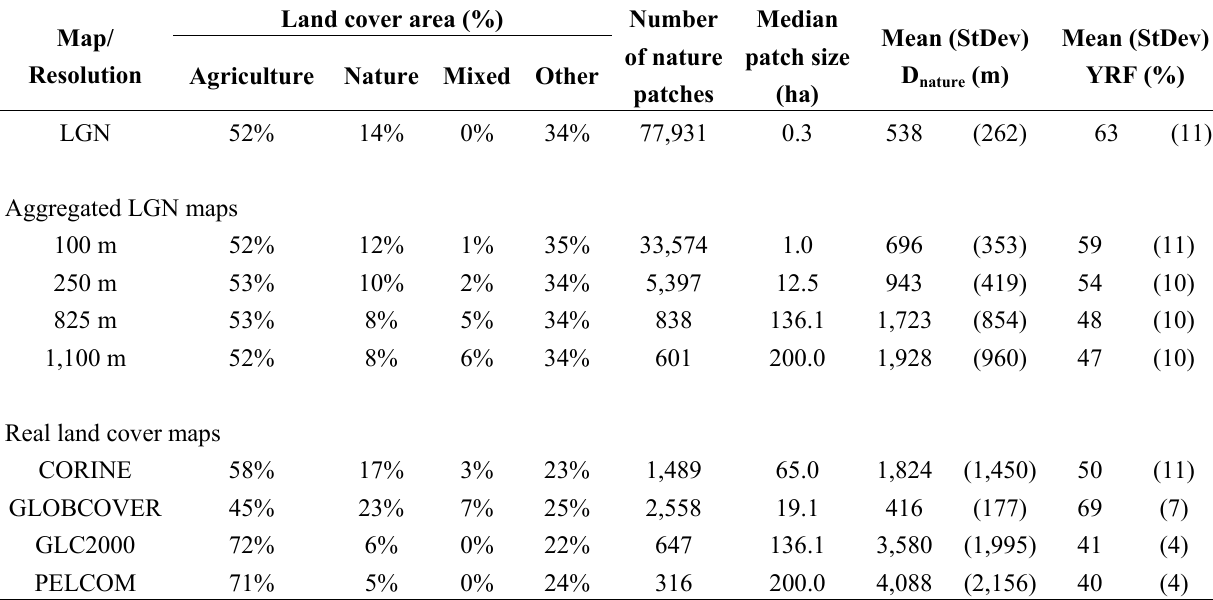
Table 3. Characteristics of land cover and ecosystem properties and functions for the study area in all land cover